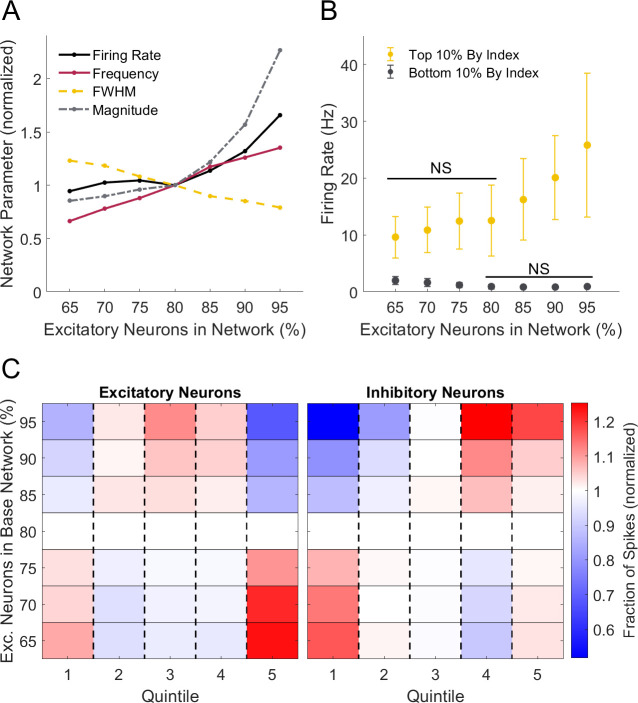
Changes in excitatory/inhibitory balance affect network dynamics.(A) Increasing the percentage of excitatory neurons in the network increased firing rate, oscillation frequency, and oscillation magnitude. In contrast, oscillation FWHM decreased with a higher proportion of excitatory neurons. All network parameters are normalized to the baseline (80% excitatory to 20% inhibitory) network. (B) The difference between average firing rate of neurons with the highest and lowest index values widened as the percentage of excitatory neurons increased. (C) As the percentage of excitatory neurons increased, the fraction of excitatory neuron spiking increased at oscillation peak and decreased at oscillation start and end, with most prominent changes occurring at the end of oscillations. With a lower percentage of excitatory neurons, opposite changes occurred with higher fractions of excitatory neuron spiking at the start and end of oscillations. As the proportion of excitatory neurons increased, the fraction of inhibitory neuron spiking decreased at start and increased at end of oscillation, with most prominent changes occurring at the start of oscillations. All spike fractions were normalized to the baseline (80% excitatory) network.